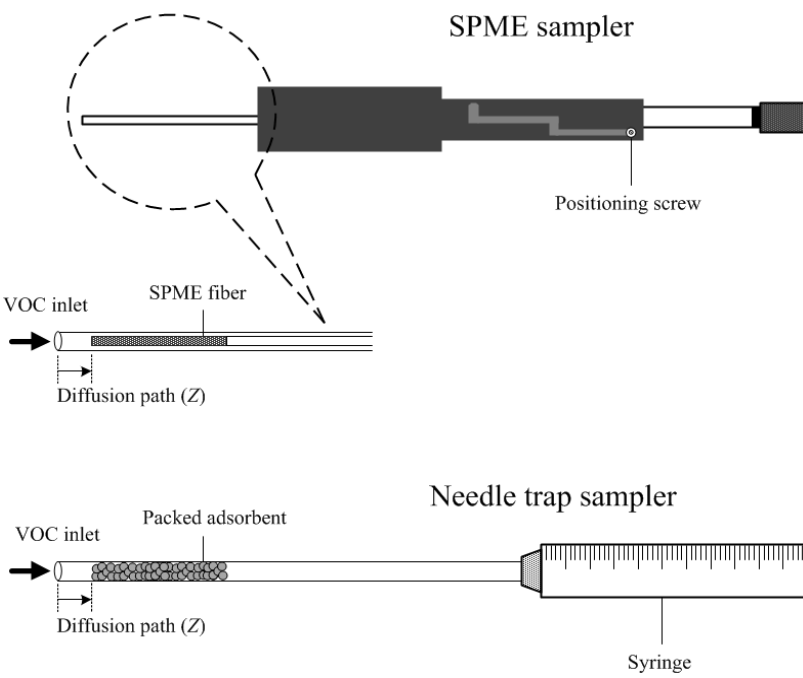
Figure 2. Schematic SPME fiber and needle trap